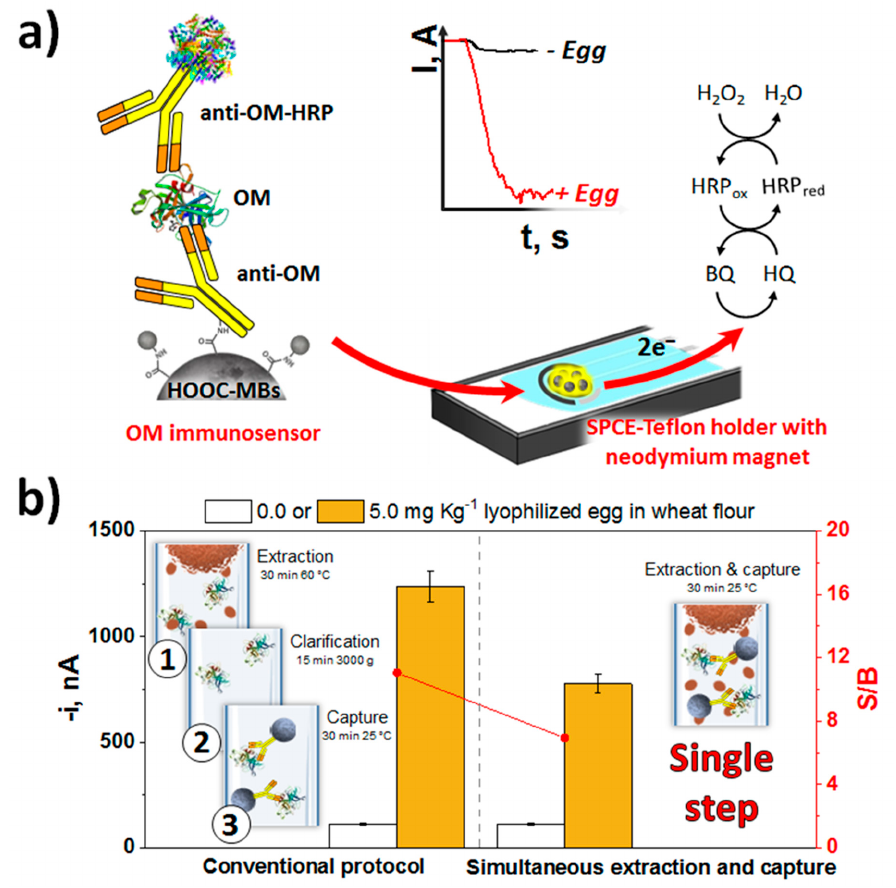
Figure 2. ( a ) Schematic display of the sandwich immunoassay involving MBs developed for the determination of ovomucoid protein and the use of the same antibody, unmodified for capturing the target allergenic protein, and conjugated with HRP for its enzymatic labeling. ( b ) Comparison of the amperometric responses obtained with the developed immunosensor for wheat flour samples unspiked or spiked with 5.0 ppm of lyophilized egg by performing the proteins extraction and the selective capture of ovomucoid by CAb-MBs in separate or single steps. Figure drawn based on